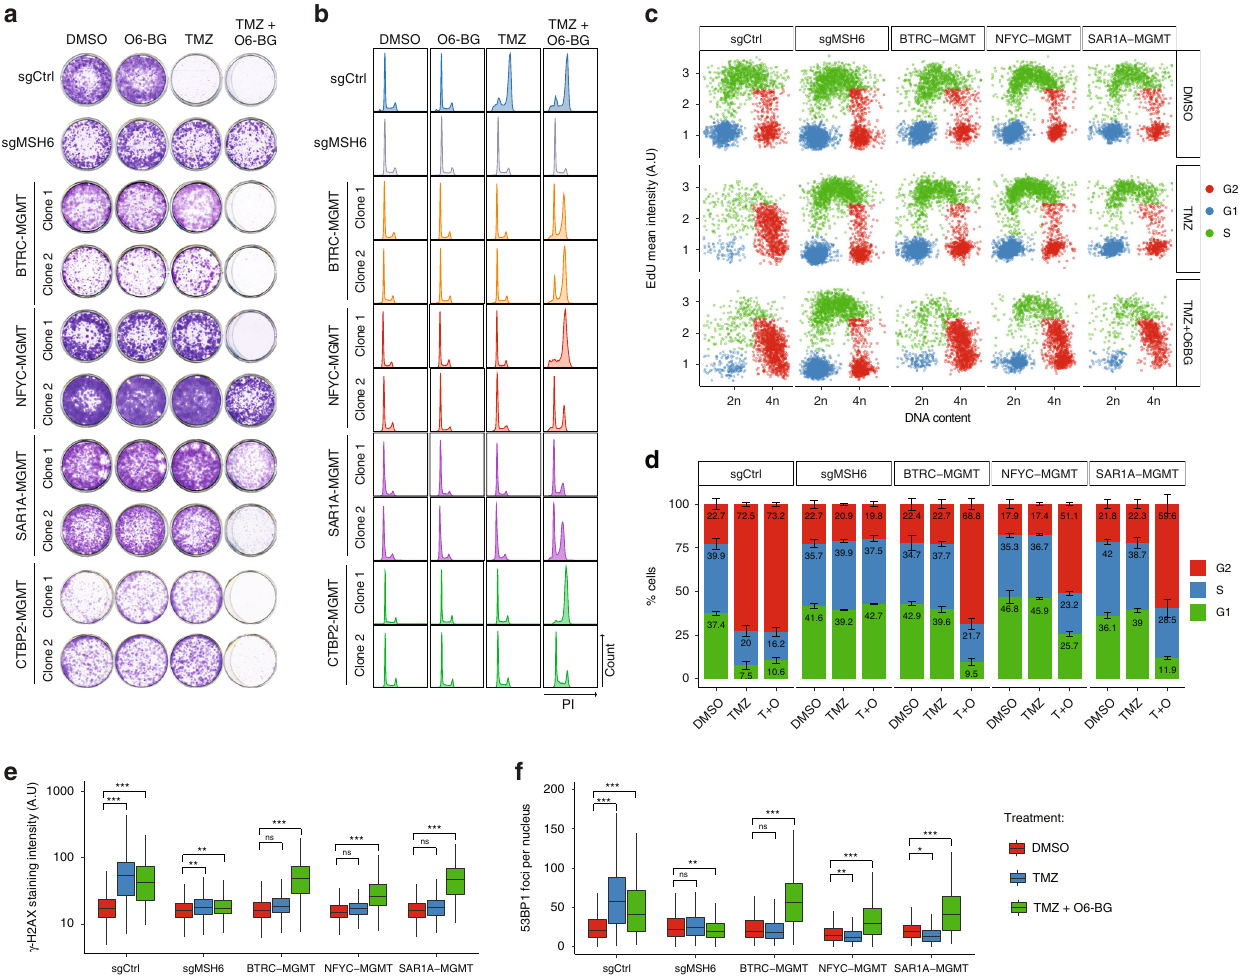
Fig. 3 MGMT fusions protect from TMZ-induced damage. a Clonogenic survival assay of U251 clones expressing MGMT fusions exposed to O6-BG (100 μ M) or/and TMZ (100 μ M) for 12 days. U251sgMSH6 cells are shown as control for TMZ resistance independently from MGMT. b Cell-cycle distribution of U251 MGMT fusion expressing cells in presence of O6-BG (100 μ M) or/and TMZ (100 μ M) for 72 h, measured by propidium iodide (PI) staining and FACS. U251 sgCtrl and sgMSH6 are shown as control. c High-throughput microscopy-mediated quanti fi cation of cell-cycle distribution at 48 h after treatment. See “ Methods ” for details. d Quanti fi cation of the percentage of cells in c . Data are from a representative experiment repeated in triplicate and presented as mean (technical replicate n = 3) and standard deviation. e , f High-throughput microscopy-mediated quanti fi cation of γ H2AX intensity levels and 53BP1 foci in U251 cells expressing the MGMT fusions after 48 h of treatment with 100 μ M of the indicated drugs. U251 sgCtrl and sgMSH6 were included as controls. The bottom and top of each box represents the fi rst and third quartiles, and the line inside is the median. The whiskers correspond to 1.5 times the interquartile range. Data are representative of n = 3 biologically independent experiments. Two-sided Student ’ s t test with Bonferroni adjustment for multiple comparisons: *** P < 0.001, ** P < 0.01, * P < 0.05, ns not signi fi cant, A.U. arbitrary unit. Source data are provided as a Source Data fi